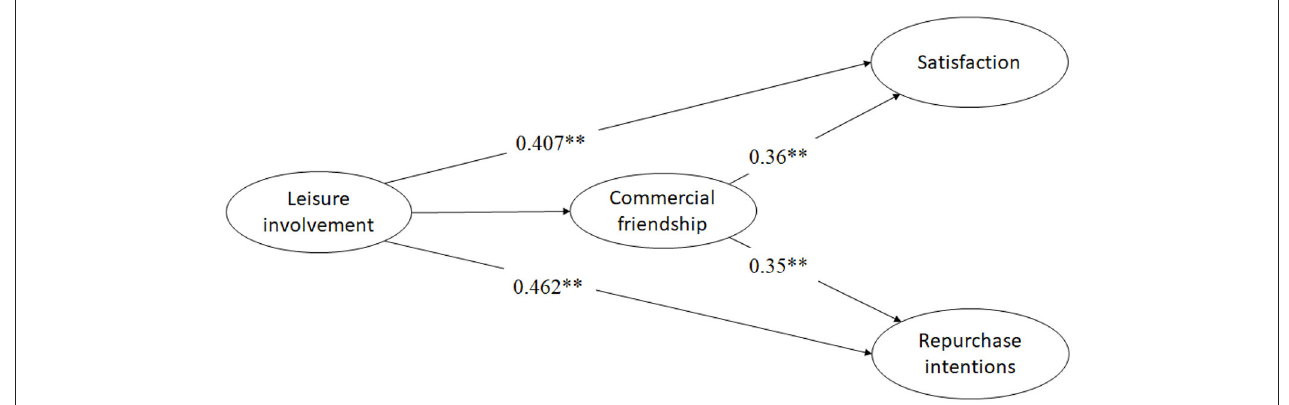
FIGURE 2 | The intermediary effect model of commercial friendship among leisure involvement, satisfaction, and repurchase intentions. ** p <